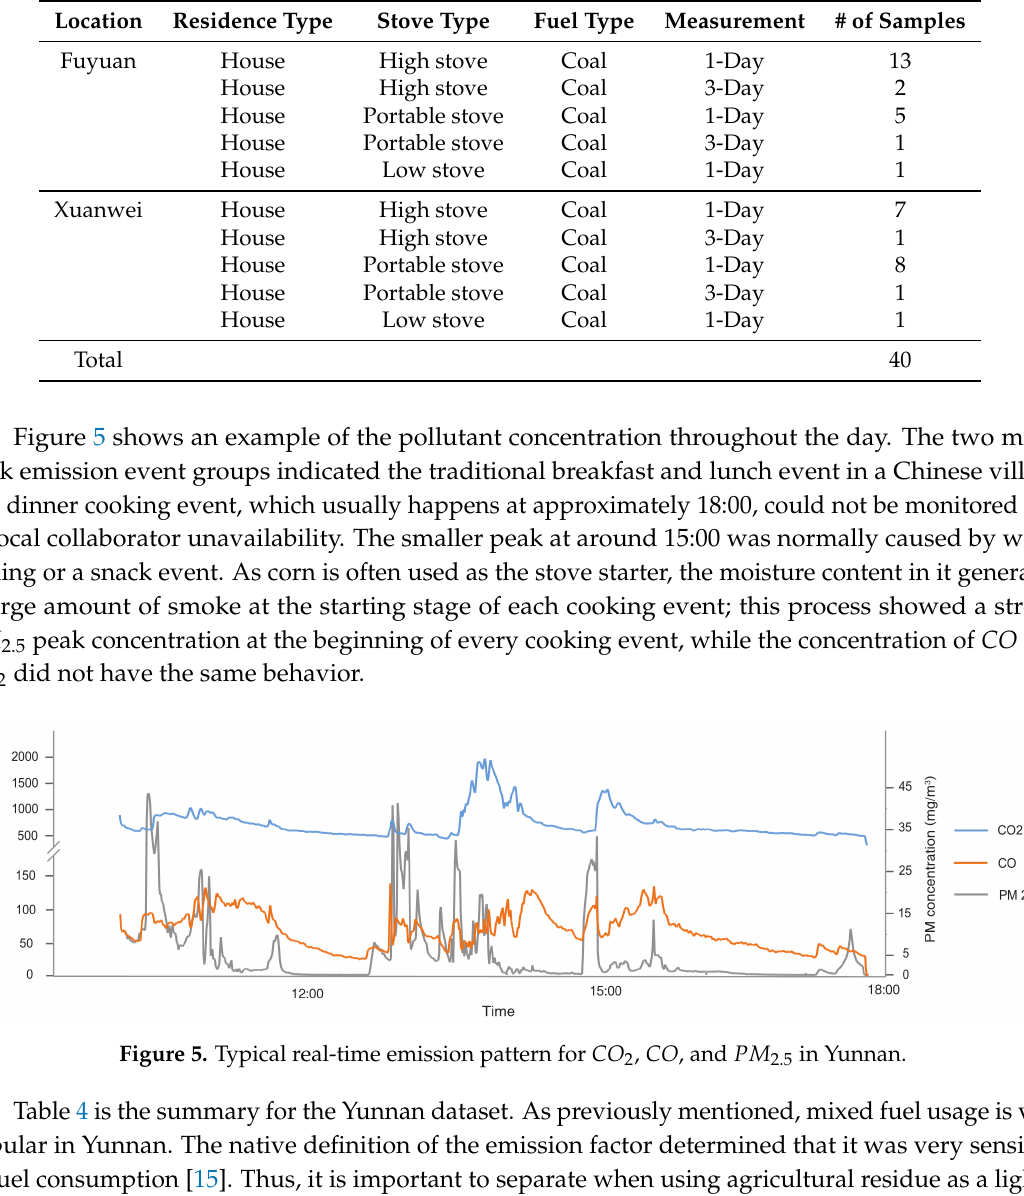
Table 3. Yunnan household summary.